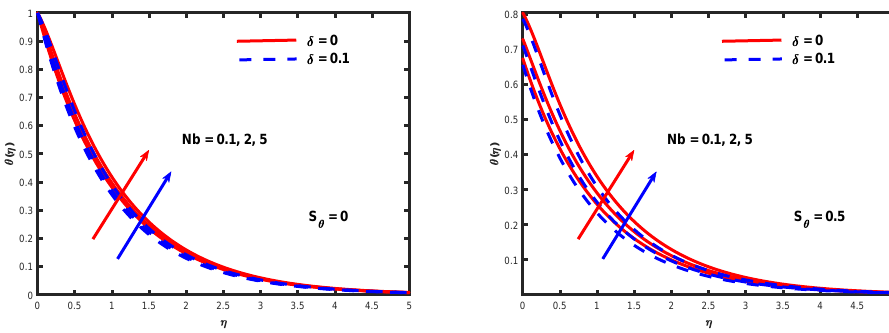
Figure 10. Influence of unsteady and Brownian motion parameter on θ .